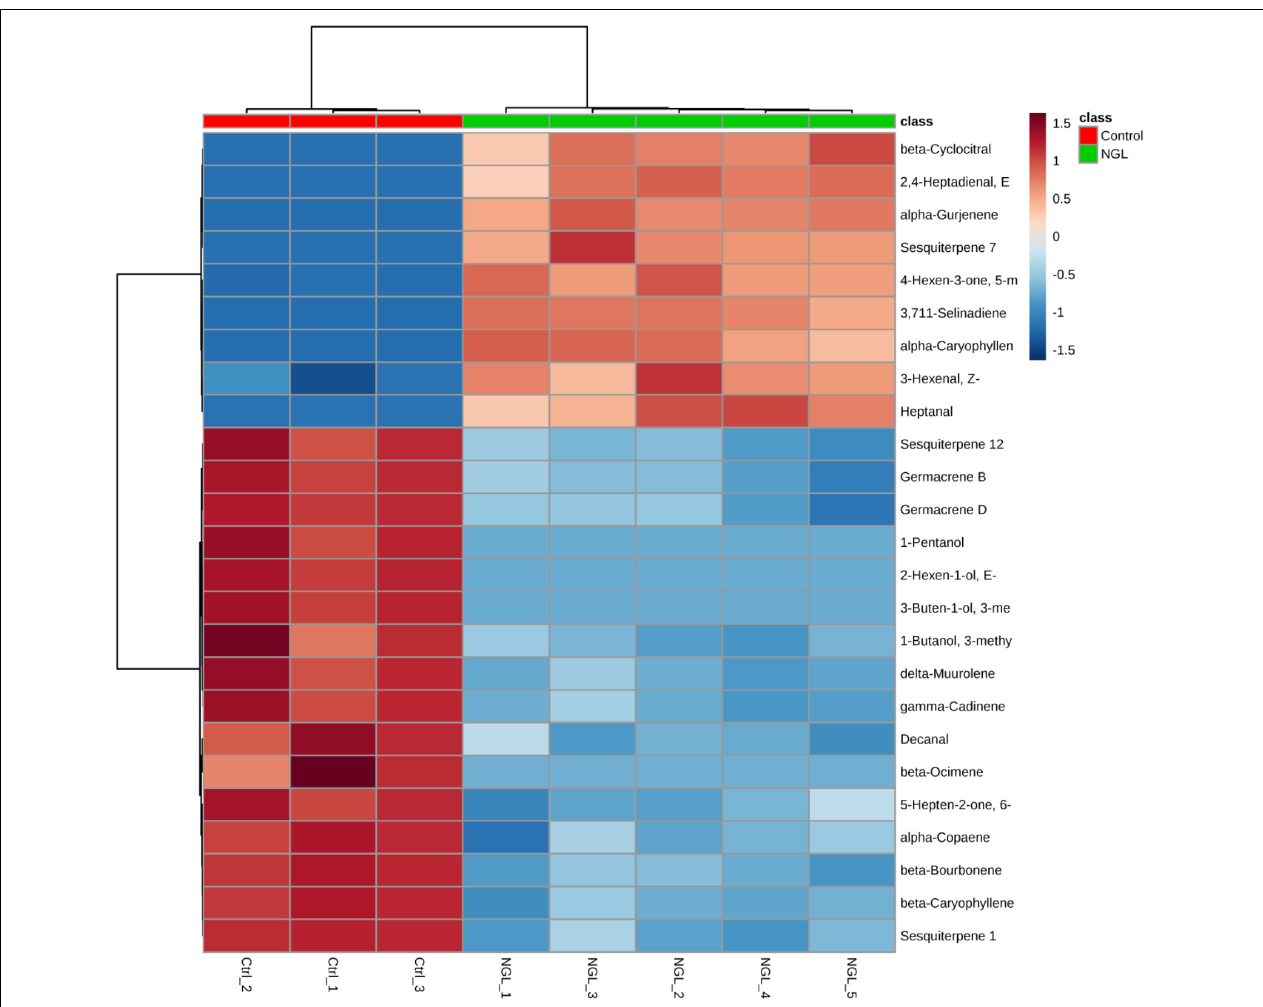
FIGURE 7 | Heat map of non-galled leaves. The heat maps were constructed based on the 25 most discriminating compounds. Compounds identified by HS-SPME-GC/MS. Color key indicates metabolite expression value, blue: Lowest, red: